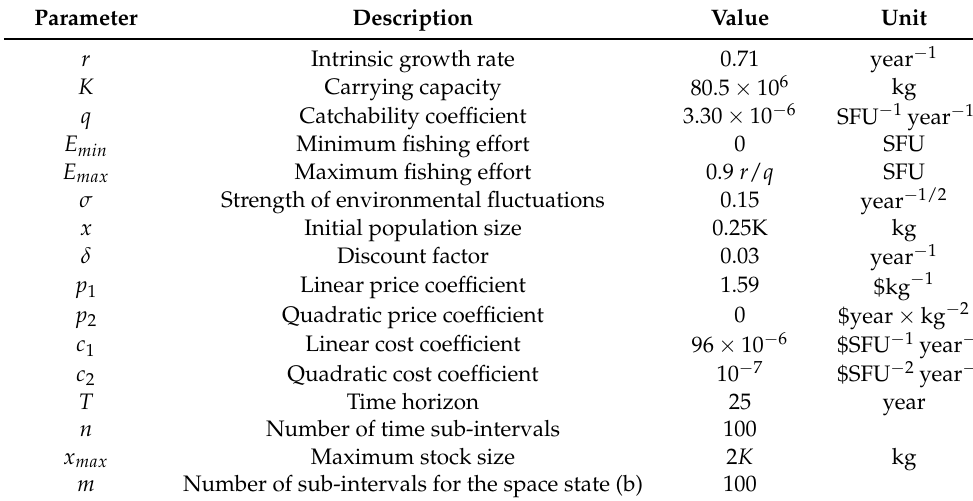
Table 1. Parameter values used to run the simulations. The definition of an SFU (Standardized Fishing Unit) is explained in [21].